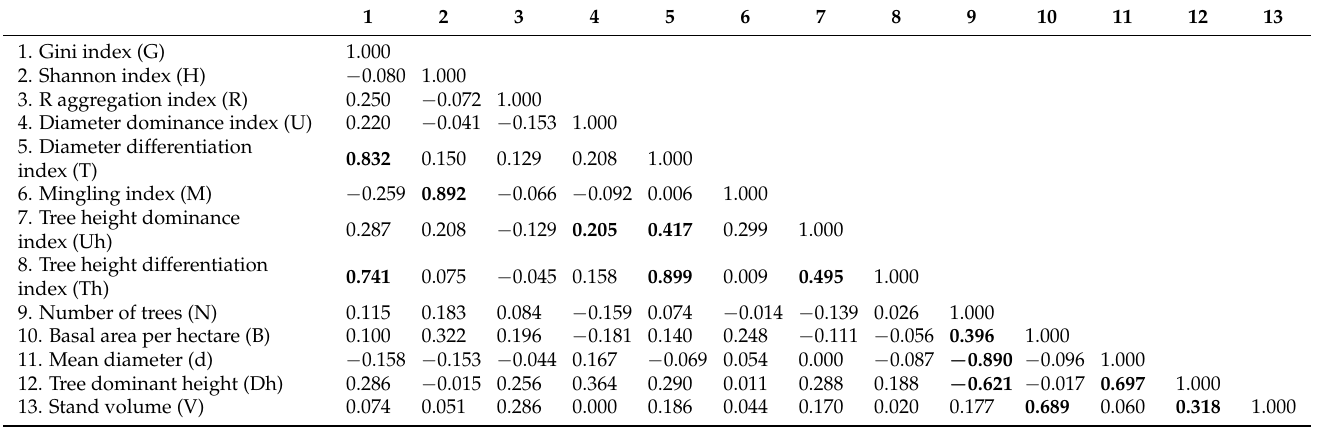
Table 3. Correlation coefficients (Spearman’s r ) between stand structural indices and stand structural parameters in the Norway spruce forest. Associations that were statistically significant ( p < 0.05) are in